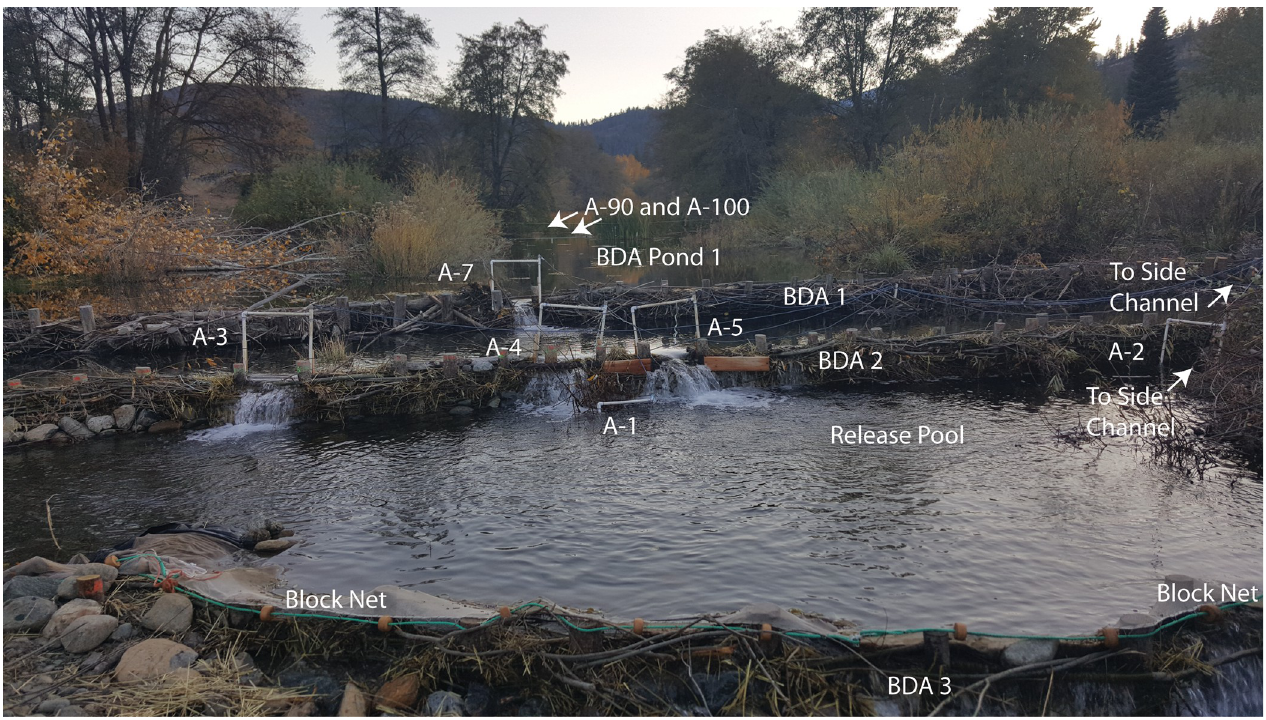
Fig 4. Experimental layout of the PIT antennas to detect fish passage across BDAs. Layout of temporary antennas and block net in fall 2017 to monitor the movement of juvenile coho salmon and steelhead trout PIT-tagged and placed in the release pool below BDA 2. Drop over BDA 1 = 27 cm, drop over BDA 2 = 40 cm. Antennas A-3, A-4 and A-5 monitored the three primary jump routes on BDA 2, while Antenna A-7 monitored the single primary jump route available on BDA 1. Antenna A-1 monitored fish in the release pool, and Antenna A-2 was one of 3 antennas that monitored fish passage on the side channels (the other two, A-6 and A-8, are not pictured). Antenna A-90 and Antenna A-100 are approximately (90 and 100 m upstream of the confluence of Sugar Creek and the Scott River, and 30 and 40 m upstream of BDA 1, respectively, and collect data year round. Just out of the picture on the right are antennas on side channels. Also not in view is another antenna below the block net, to detect for any downstream movement past the block net. Note the recently beaver-felled cottonwood (golden leaves) in upper left of